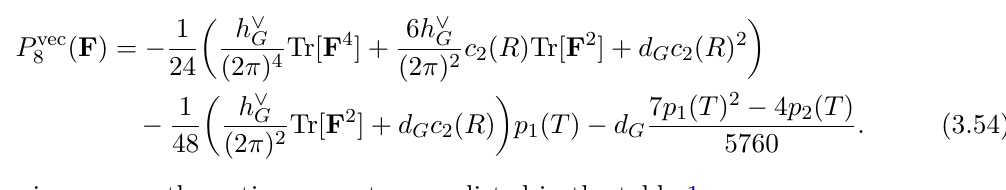
Table 1 . Group-theoretic constants for ADE type. We follow the convention of [14]. where F is a field strength of the flavor symmetry G 0 ,N vector multiplet P vec 8